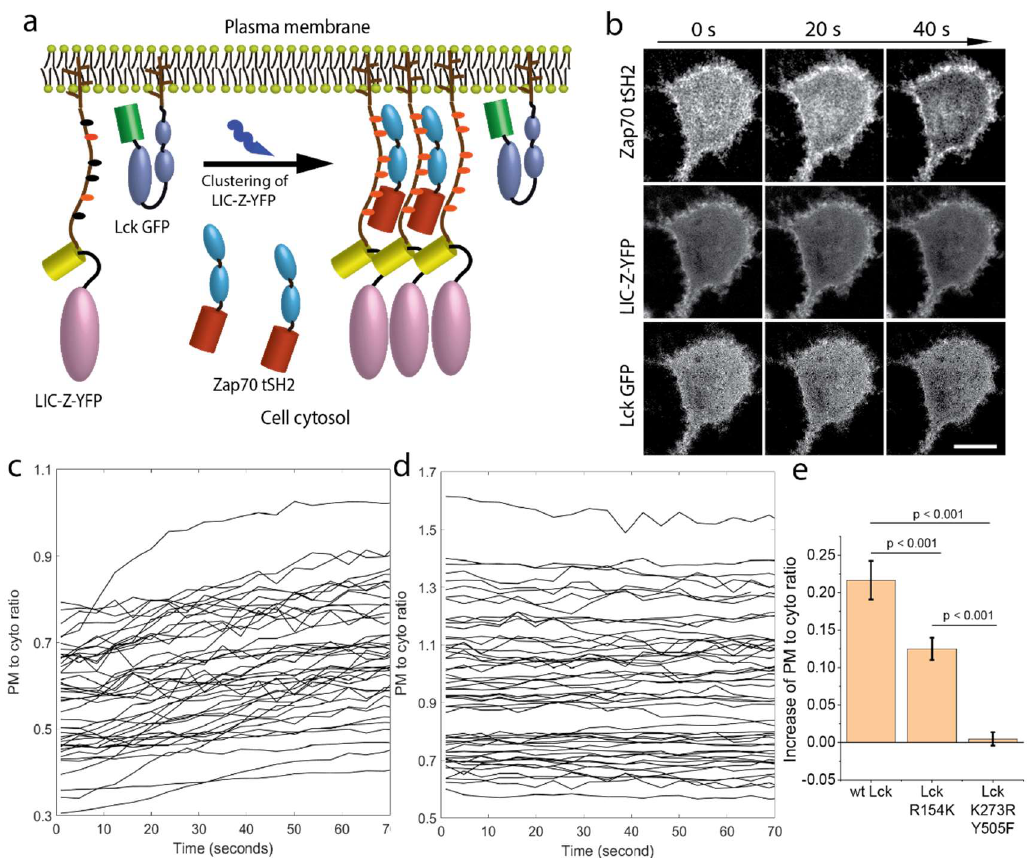
Figure 5. Reconstituting and imaging ζ -chain triggering in COS-7 cells. ( a ) Schematics of reconstituting ζ -chain triggering in COS-7 by co-expressing LIC-Z-YFP, Lck GFP and the mCherry-tagged tandem SH2 domain of Zap70 (Zap70 tSH2). Prior to ζ -chain triggering, Zap70 tSH2 di ff uses freely in the cytosol. Upon light-induced clustering, ζ -chain triggering is read-out as the translocation of Zap70 tSH2 from the cytosol to plasma membrane since Zap70 tSH2 binds specifically to phosphorylated ITAMs on the LIC-Z-YFP. ( b ) Representative live cell confocal images of light-induced clustering of LIC-Z-YFP (top row), distribution of Zap70 tSH2 (middle) and Lck GFP (bottom). Scale bar = 20 µ m. ( c , d ) Quantification of Zap70 tSH2 ( c ) and LIC-Z-YFP ( d ) intensity at the plasma membrane relative to the cytosol immediately after irradiation. Each line represents one cell. ( e ) Quantification of Zap70 tSH2 recruitment to the plasma membrane for cells expression wild-type Lck, Lck with a mutation in the SH2 domain (Lck R154R) or open and kinase dead Lck (Lck K273R Y505F) prior and post light induced clustering of LIC-Z-YFP. Zap70 tSH2 intensity ratio is shown as a fold-change relative to the first four imaging frames. Data are mean and standard error of n = 40 cells. One-way ANOVA with Fisher LSD post hoc test.